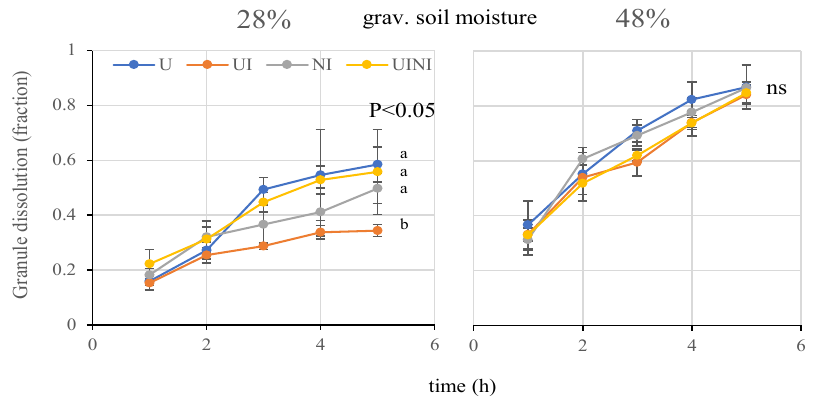
Figure 3. Urea granule dissolution rates of 4 urea-based fertilizers at gravimetric soil moisture levels of 24% and 48%, and 20 ◦ C temperature in a soil-filled Petri dish incubated in a climate chamber (70% air humidity). Test of final dissolution level with one-way ANOVA and Tukey’s post hoc test ( p < 0.05). Error bars represent standard deviation ( n = 4).